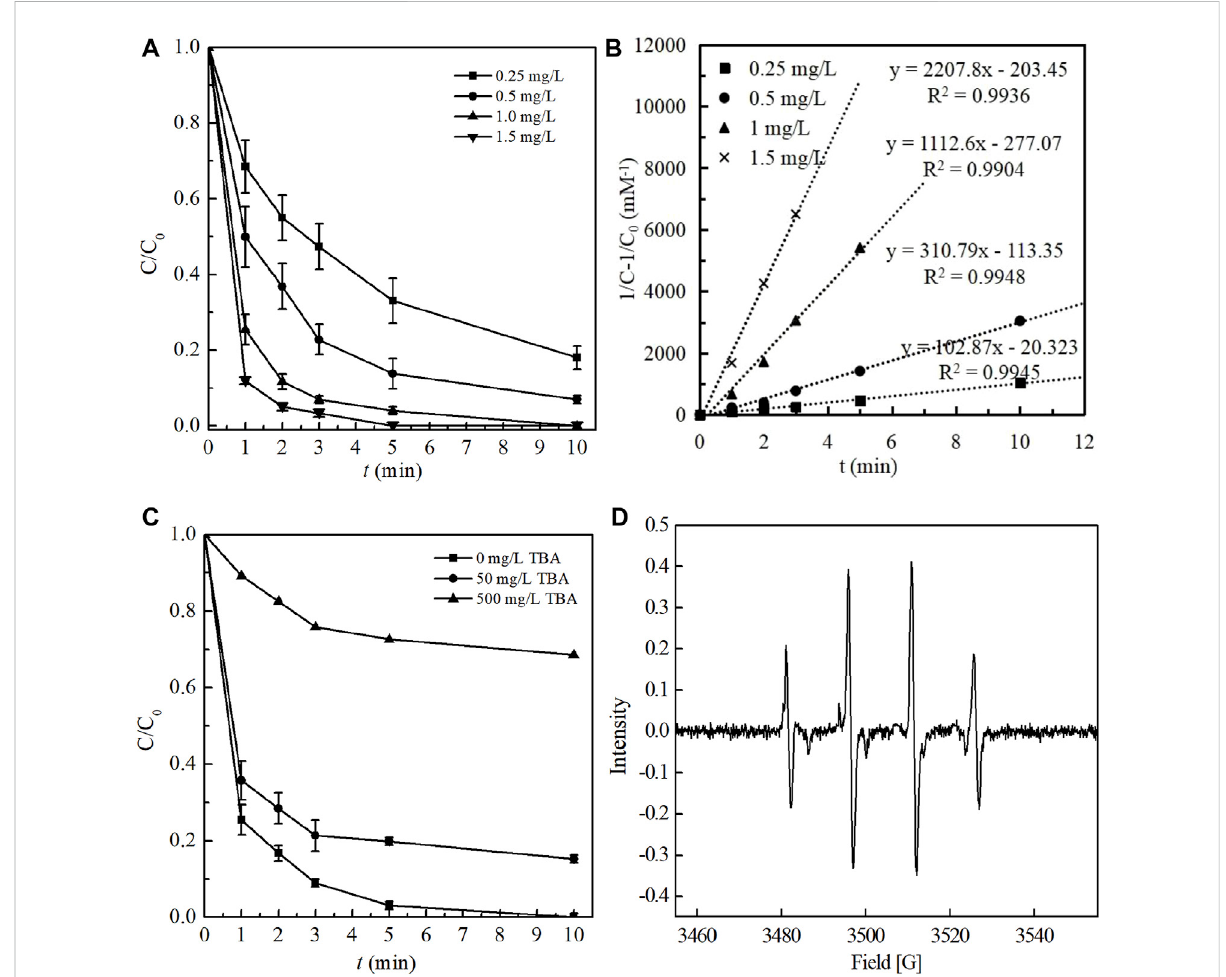
FIGURE 1 (A) Effect of ozone dosage on BPA degradation and (B) Kinetic fi tting under different ozone dosage (Experimental conditions: temperature = 25±1 ° C;initialsolutionpH=7.0[BPA] 0 =1.00 mg/L;ozonedosageof0.25,0.5,1.0,1.5 mg/L); (C) Thefreeradicalscavengingexperimentsbyadding TBA and (D) EPR spectra during ozonation system (Experimental conditions: temperature = 25 ± 1 ° C; initial solution pH = 7.0 [BPA] 0 = 1.00